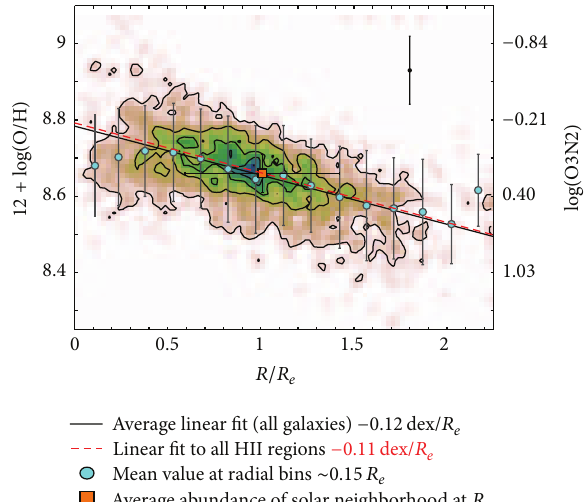
Figure 6: Radial oxygen abundance density distribution for the whole HII region spectroscopic sample discussed in the text. The first contour indicates the mean density, with a regular spacing of four times this value for each consecutive contour. The light-blue solid circles indicate the mean value (plus 1 − 𝜎 errors) for each consecutive radial bin of ∼ 0.15 𝑅 𝑒 . The average error of the derived oxygen abundance is shown by a single error bar located at the top- right side of the panel. The solid-orange square indicates the average abundance of the solar neighbourhood, at the distance of the Sun to the Milky-Way galactic center. The lines represent linear fits to all galaxies (black) and all HII regions (dotted red) independently, showing a universal slope ∼− 0.1dex/ 𝑅 𝑒 . Figure is adapted from Rosales-Ortega et al.